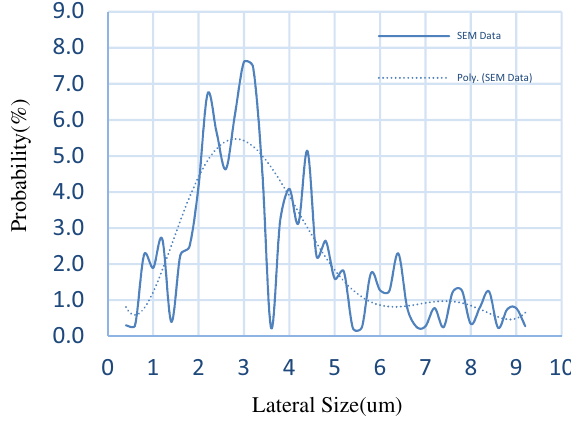
Fig. 1 The probability distribution functions are used to generate lateral size of the graphene flakes on the model (adapted from